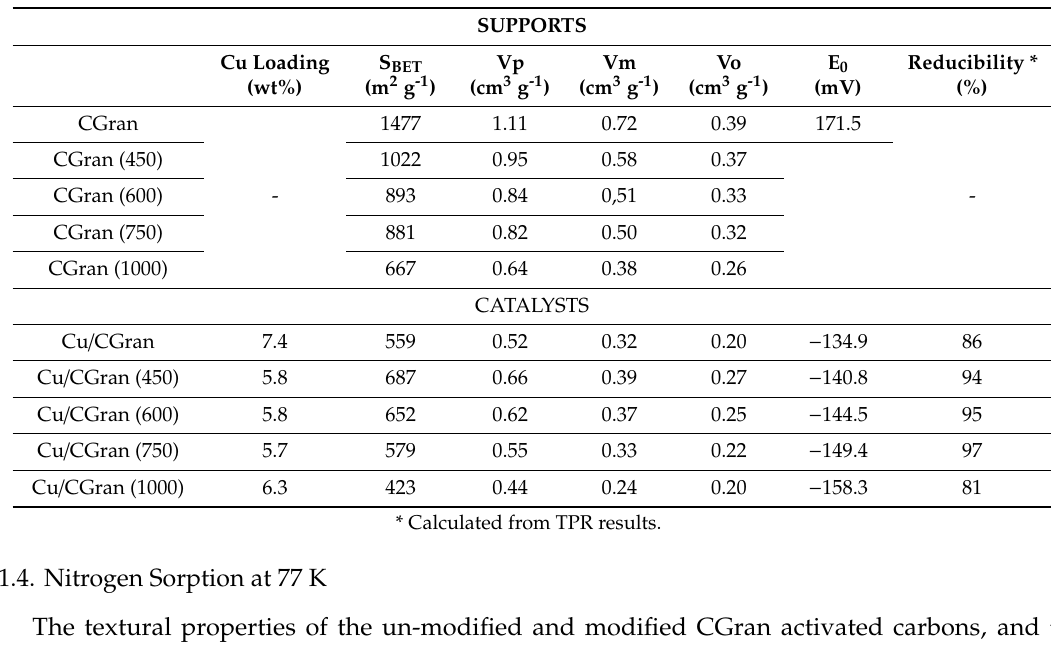
Table 1. Physical and chemical properties of the CGran(x) supports and Cu/CGran catalysts SUPPORTS